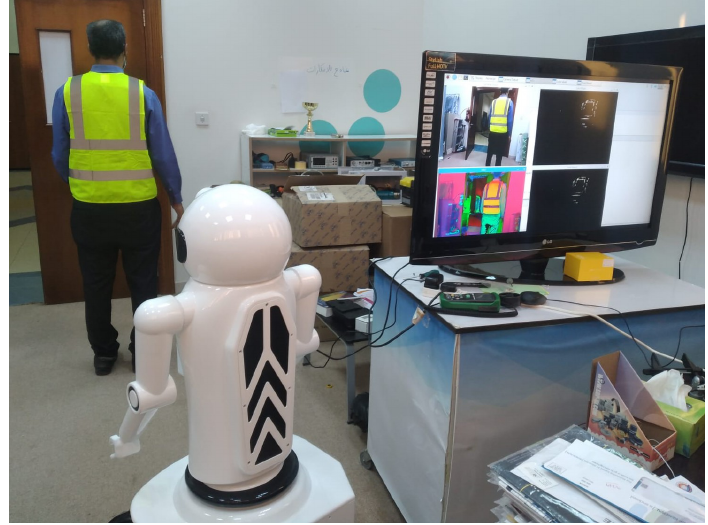
Figure 13. Safety jacket color